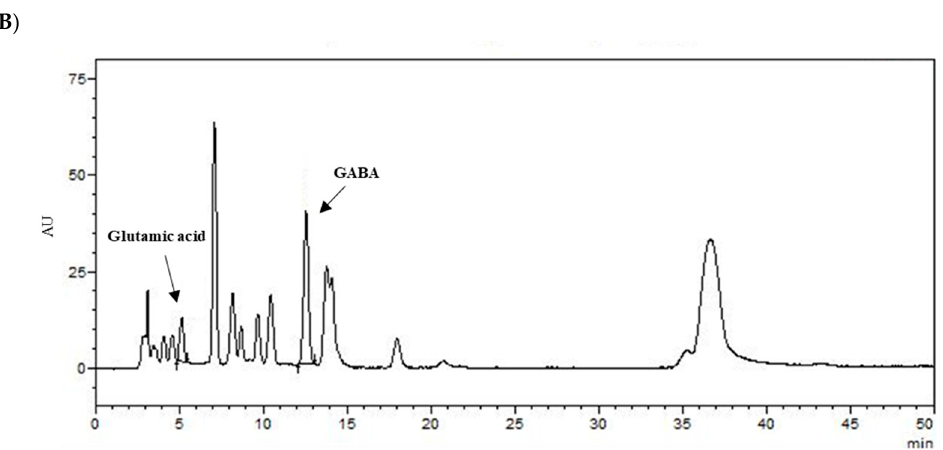
Figure 1. HPLC chromatograms of glutamic acid and GABA standard solution ( A ) and Oryzae sativa extracts ( B ).